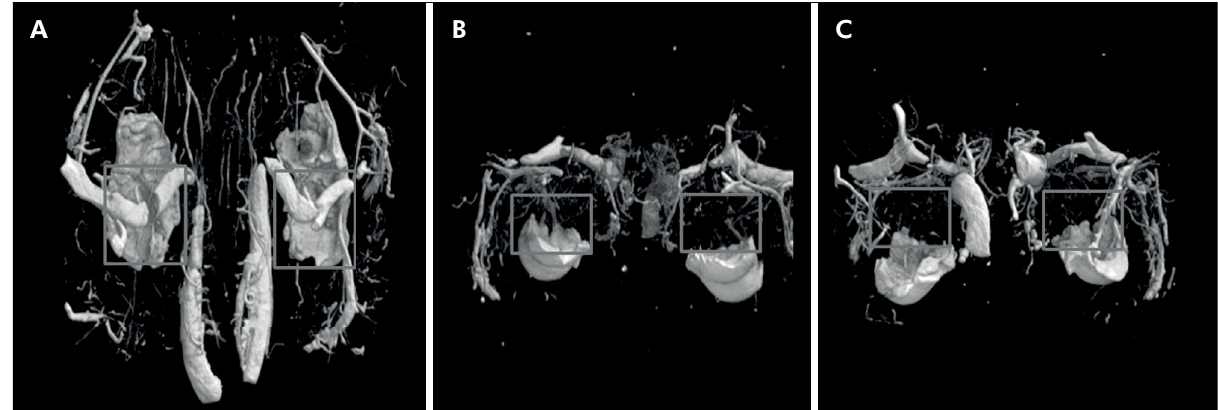
Figure 2. The occlusal (A), frontal (B) and rear (C) views of the blood vessels in the maxilla at 1 week after surgery (0.5 mm and 1.0 mm displacement groups). Each image within the solid line box (3.5 x 4.5 x 2.5 mm 3 , horizontal, vertical, height measurements, respectively) was analyzed. The GI cement appeared